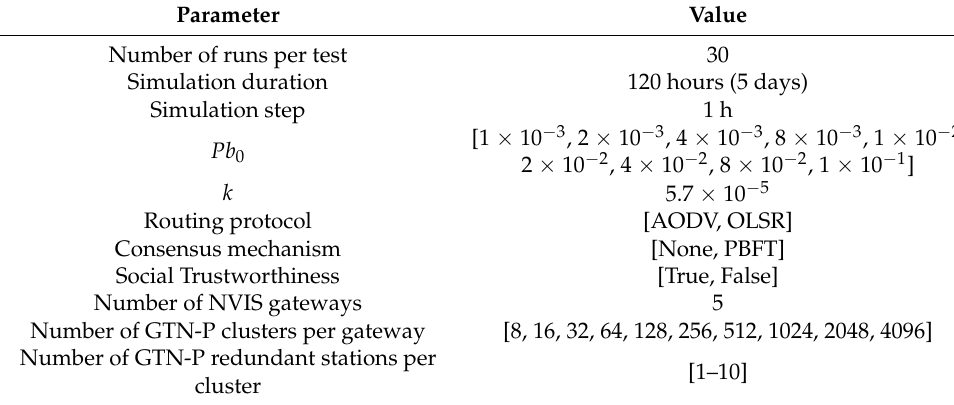
Table 4. Simulation